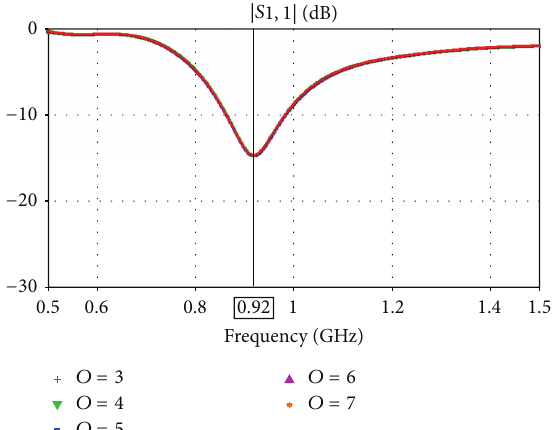
Figure 13: Resonance frequency of triple-layers strip dipole antenna with difference curving radius (millimeters).